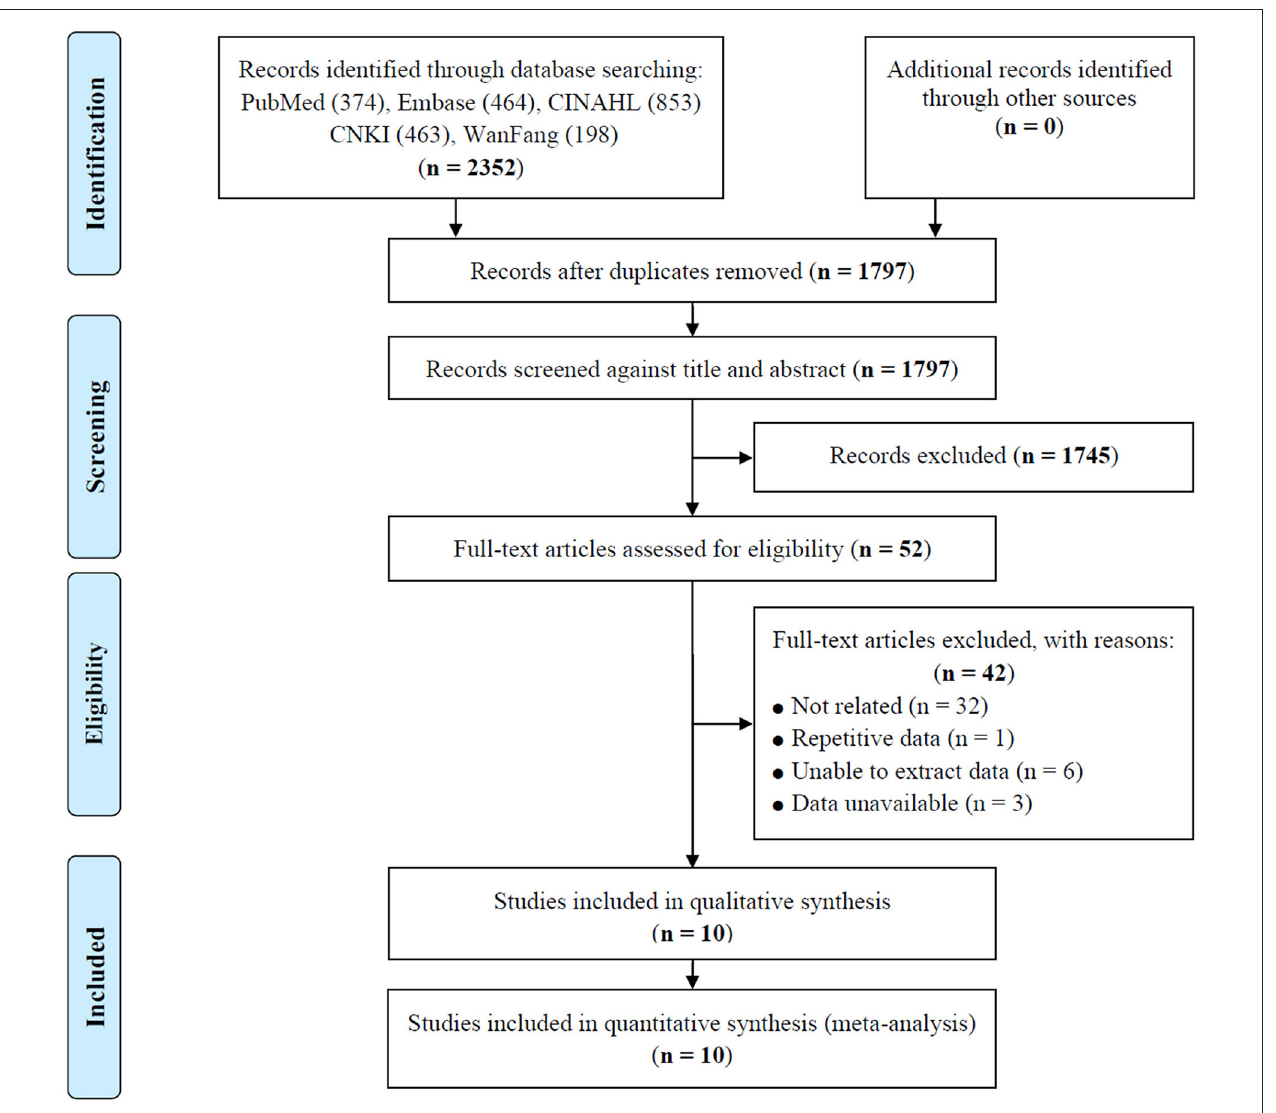
FIGURE 1 | Flow diagram of study